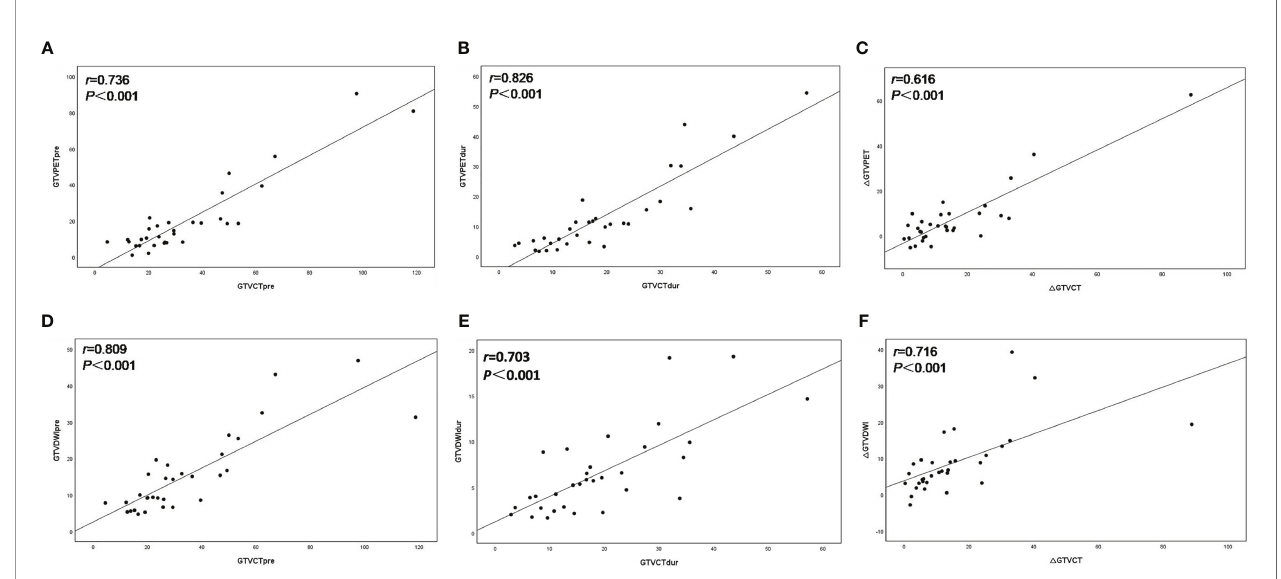
FIGURE 1 | Scatter plots of correlation between the target volume delineated on 18 F-FDG PET – CT (GTV PET ) and DW-MRI (GTV DWI ) and on the corresponding CT (GTV CT ) before and during radiotherapy. The best- fi t line is shown as the solid line for each scatterplot. (A) GTV PETpre versus GTV CTpre ; (B) GTV PETdur versus GTV CTdur ; (C) D GTV